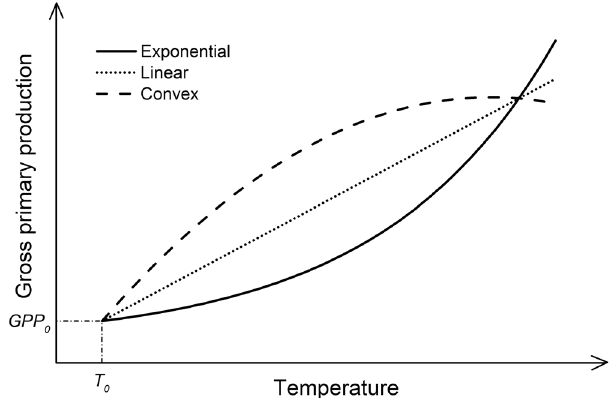
Figure 5. Conceptual models of the gross primary production (GPP) rates vs.